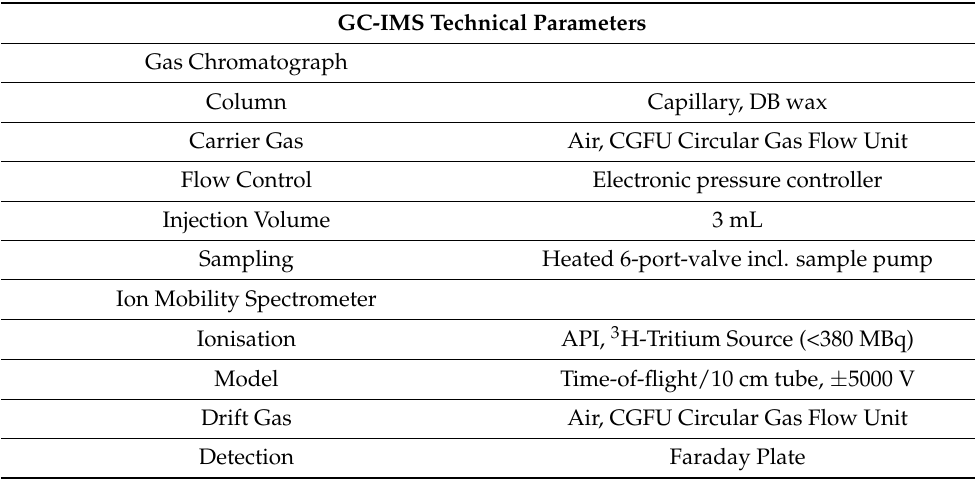
Table 2. Experimental conditions of GC–IMS device. Technical parameters have been schematised both for chromatographic elution (column, carrier gas, flow control, injection volume, and sampling) and ion mobility mass spectrometry (ionisation, model, drift gas, and